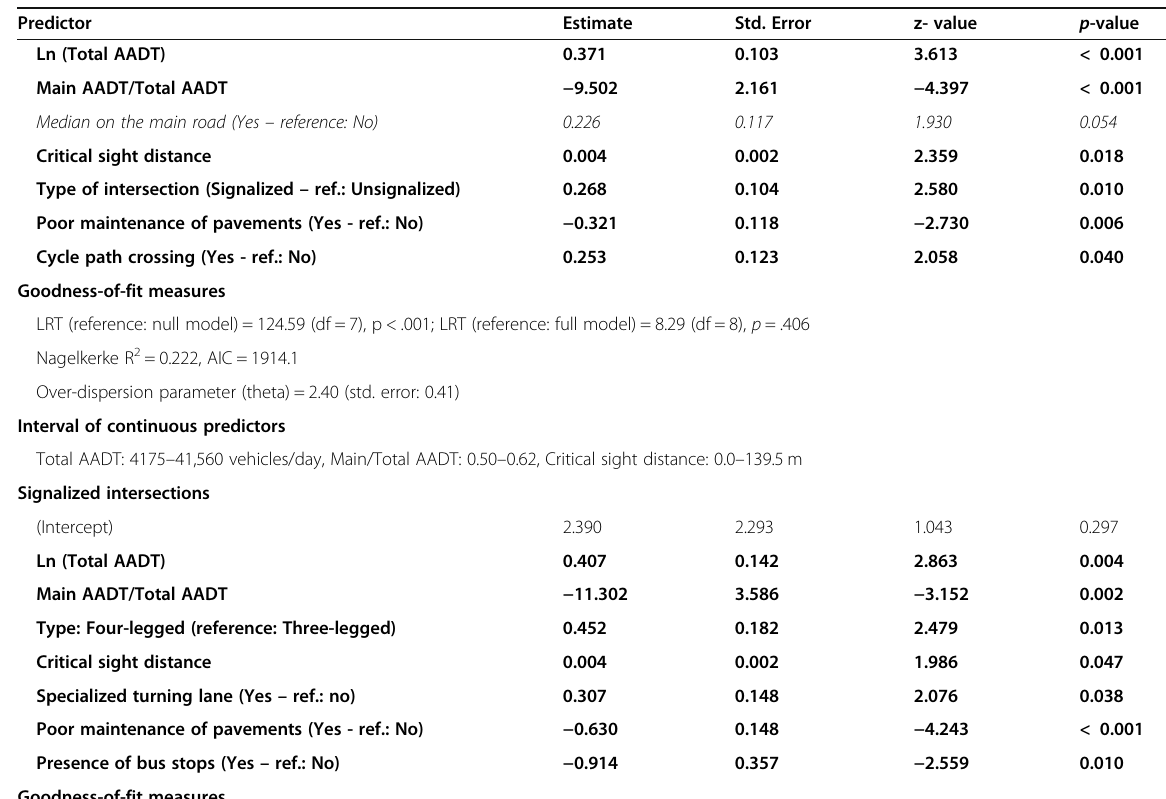
Table 3 Selected models for intersections